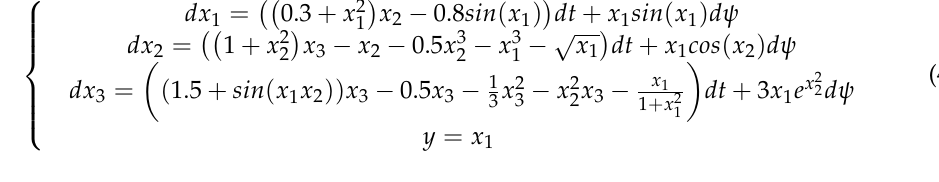
Figure 7. The control signals of the three controllers in Figure 6.